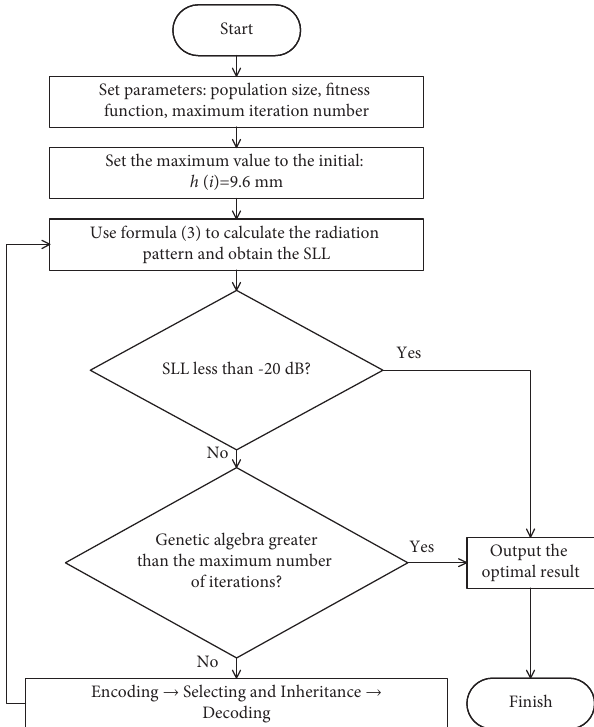
Figure 4: Flowchart of the genetic algorithm.